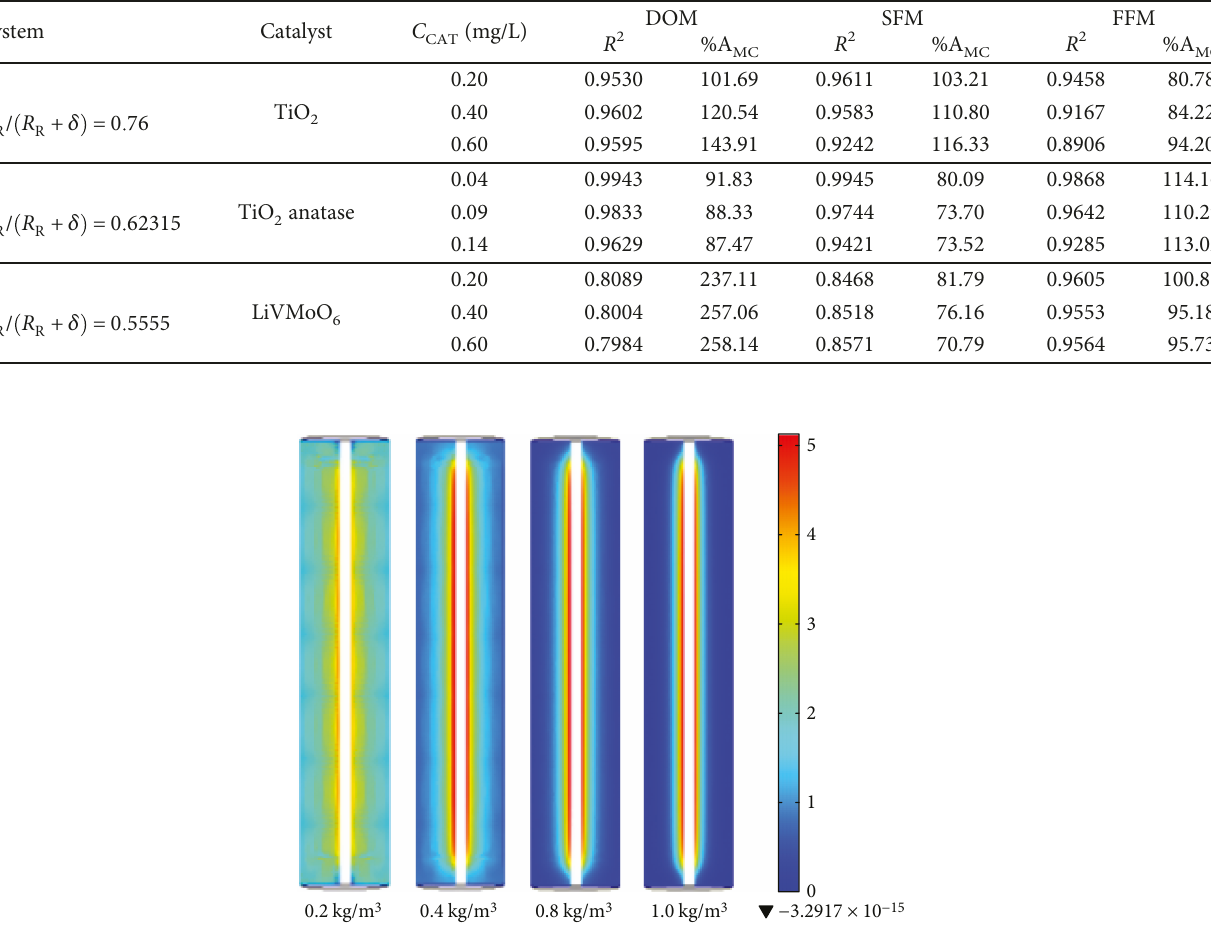
Figure 9: E ff ect of catalyst concentration on the reactor radial section where photon absorption occurs (LVREA map) in system 3.